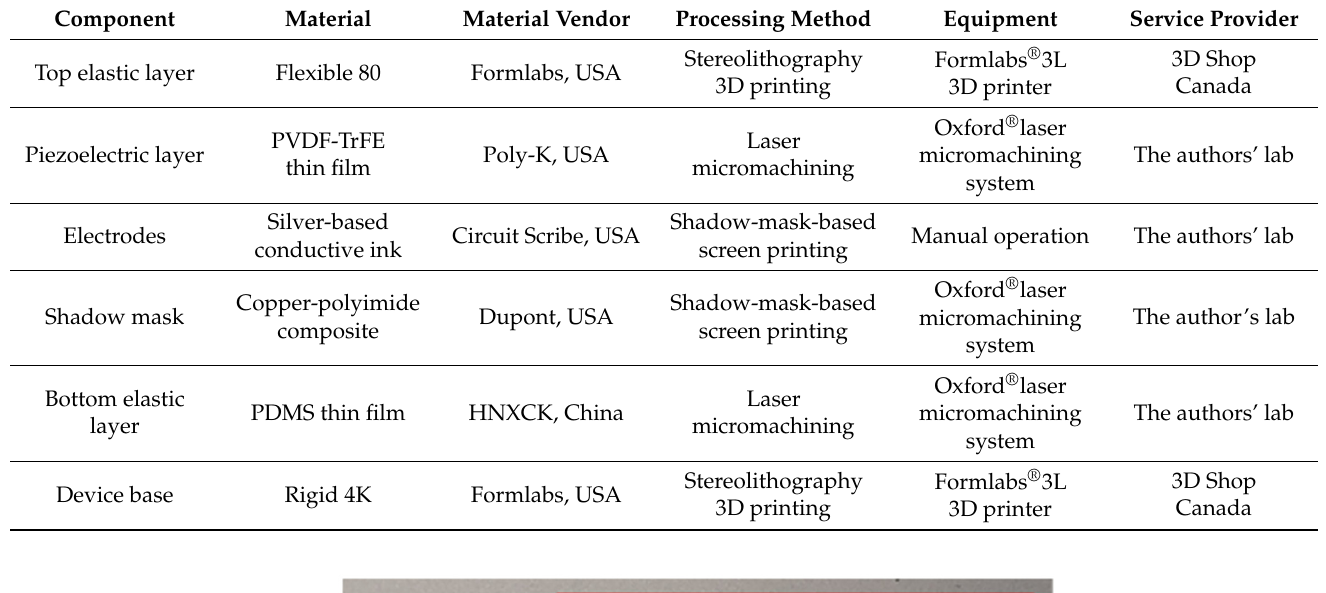
Table 1. Material, equipment, and processes used to fabricate the piezoelectric tactile sensor.